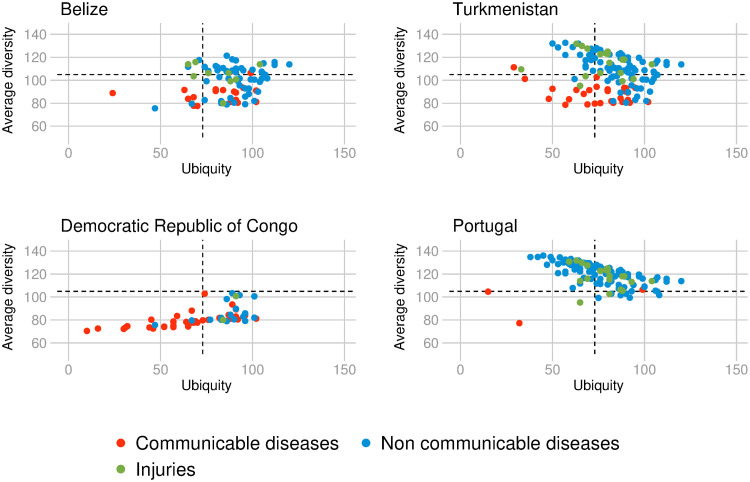
Ubiquity and average diversity of diseases in four selected countries.Relationship between ubiquity and average diversity of diseases for which the country (respectively Belize, Turkmenistan, the Democratic Republic of Congo and Portugal) has a Relative Disease Disadvantage (RDD). The colors depict different disease types. Data for 2016.